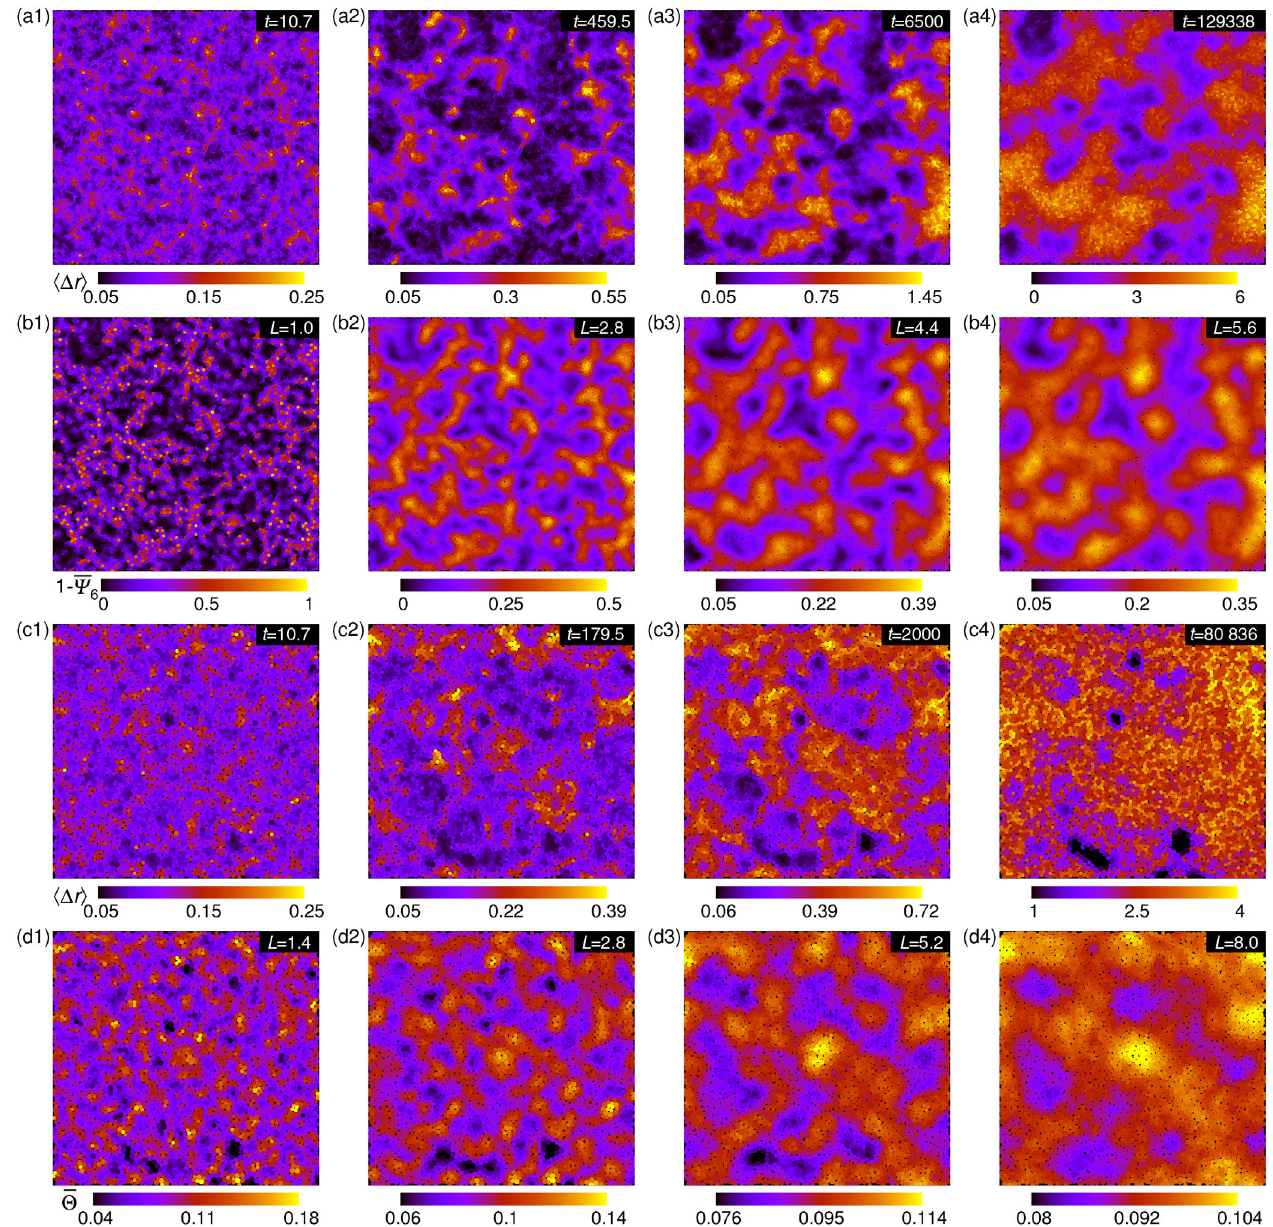
FIG. 2. Illustration of correlation between structural order and dynamic heterogeneity. Top two rows: 2D polydisperse disk system (polydispersity Δ ¼ 11% ) at T ¼ 2 × 10 − 3 , with a corresponding α relaxation time τ α ≈ 6541 . (a1) – (a4) Spatial distribution of dynamic ¯ Ψ propensity h Δ r i at different timescales. (b1) – (b4) Spatial distribution of 1 − 6 (the degree of disorder) of the initial configuration of the isoconfigurational ensemble for (a) at different coarse-graining length scales L . Bottom two rows: 2D binary disk system at ¯ Θ T ¼ 1 . 5 × 10 − 3 , with τ α ≈ 1942 . (c1) – (c4) Spatial distribution of h Δ r i at different timescales. (d1) – (d4) Spatial distribution of (the degree of disorder) for the same system as (c) at different coarse-graining length scales L . Note the clear resemblance in the same column, which indicates a structure-dynamics correlation at corresponding time and length scales. The similarity between the dynamic and static patterns is maximized for the third column for both polydisperse and binary systems (see text on its implication). See Secs. II and III for the definitions of structural order parameters and simulation details, and Appendix A, Fig. 8, for structural orders without coarse